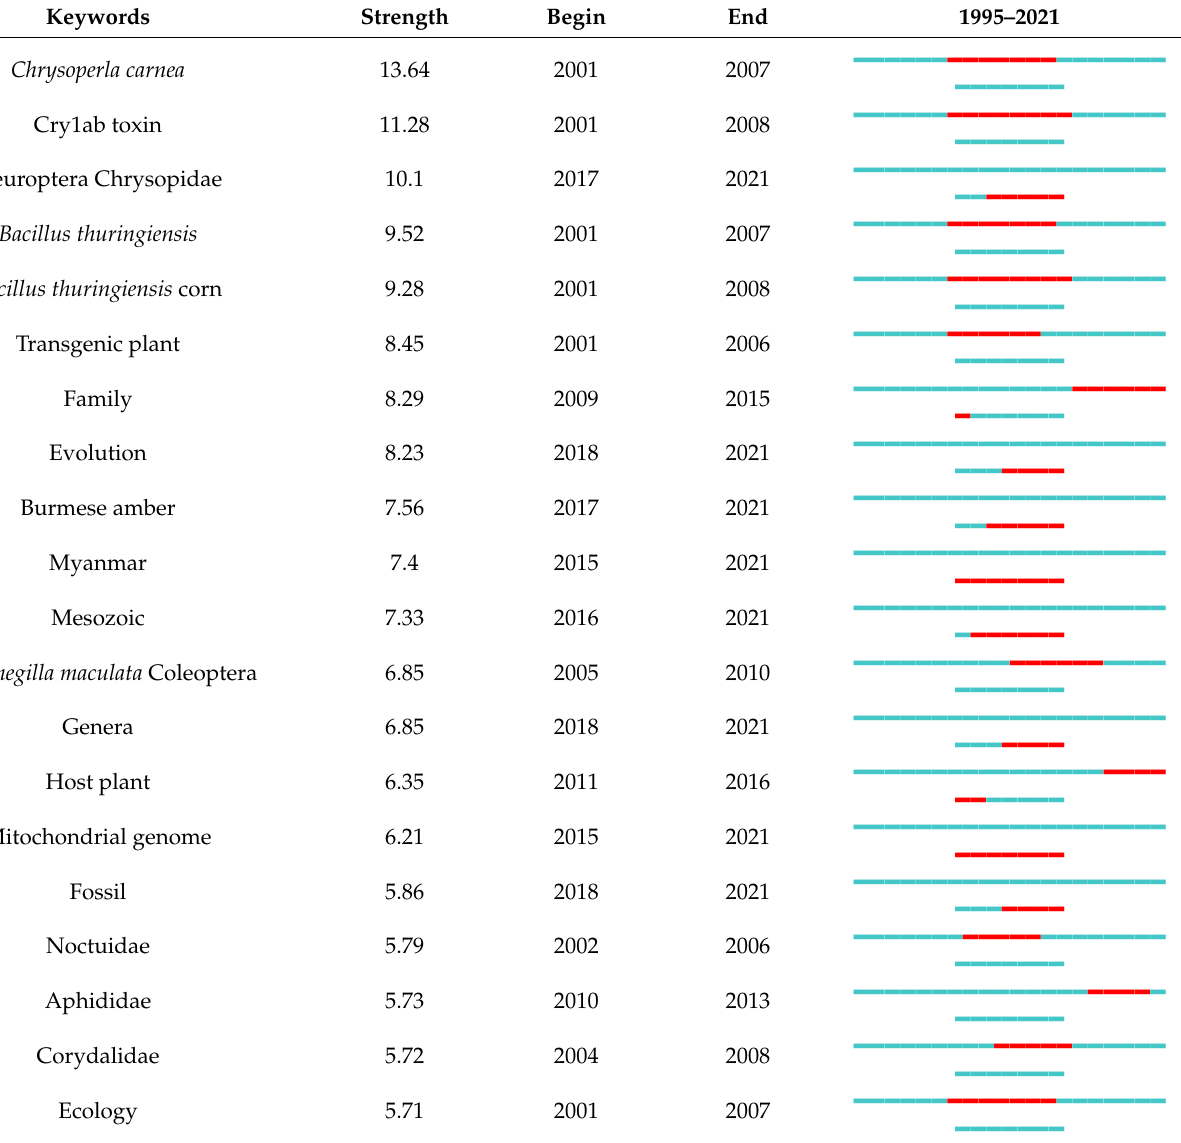
Table 10. Top 20 keywords based on citation burst